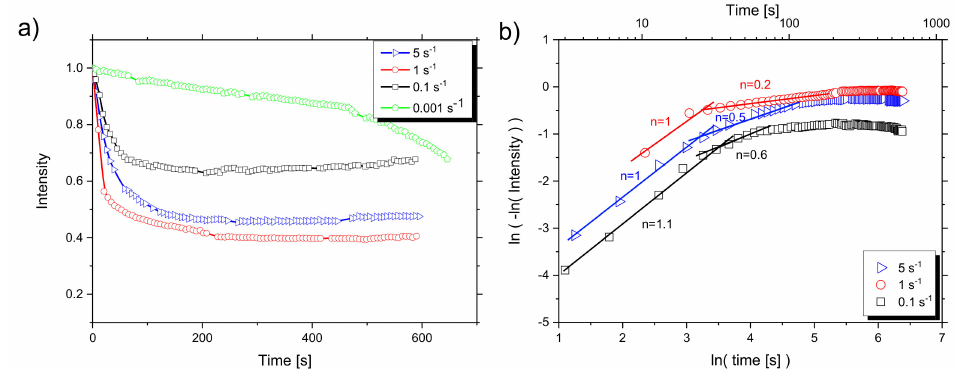
Figure A1. Normalized intensity evolution as a function of time during heat treatment after compression for the β -211 plane. ( b ) A double logarithmic scale of ( a ) after Equation (3). Straight lines indicate the linear fit and besides corresponding slopes ( n -exponent) are indicated.